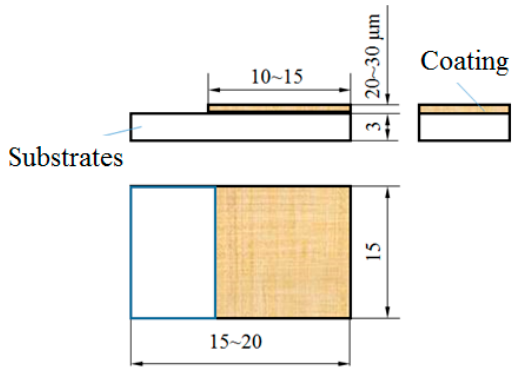
Figure 7. Specification of the sample under test and the dimensions of the surface film.